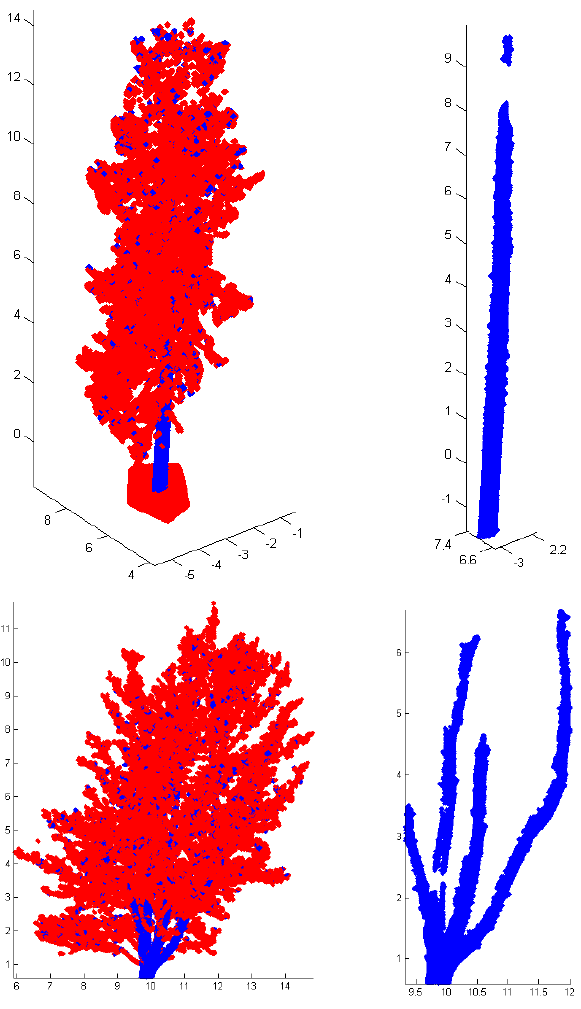
Figure 6: Classification of trunk points. Top: The blue points denote the cover sets that are initially classified as trunk points ( r = 0 . 03 , p t = 0 . 8 , e t = 3 , f t = 15 ). Bottom: The final classification of trunk points, where only the largest components (over 2000 points) of the initial classification are accepted.